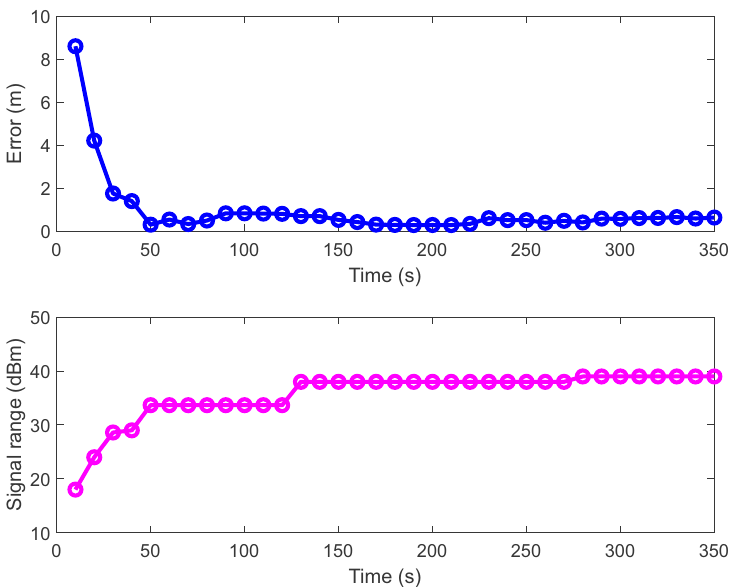
Figure 5. The upper part of the figure shows the error between the beacon’s actual location (with MAC address DA:57:30:EC:6A:D1) and the position calculated by the constrained nonlinear optimization method. The error depends on the time or the travelled distance. The lower part of the figure shows the BLE signal range (the difference between maximum and minimum signal strength) as a function of time or the travelled